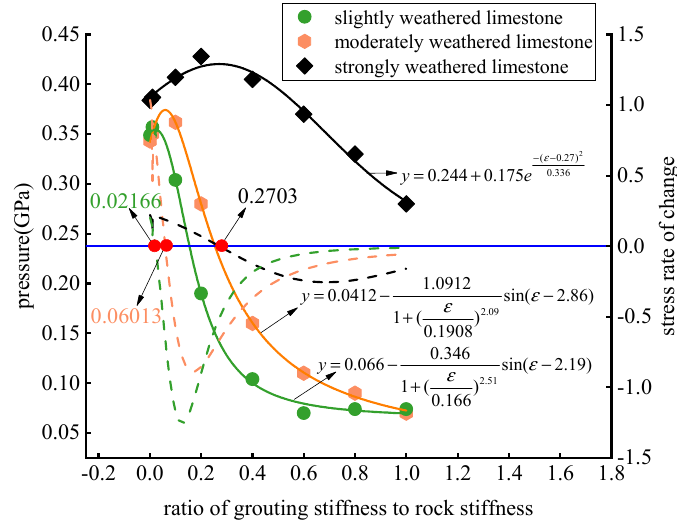
Figure 16. Stress analysis of cement mortar with different stiffness.